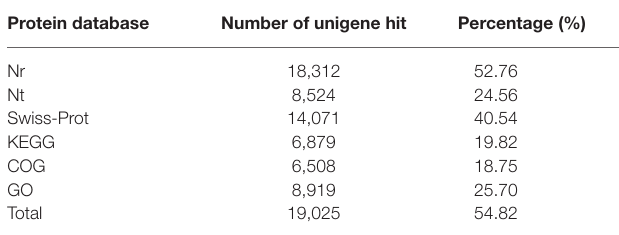
TABLE 1 | Annotations of H. parallela unigenes in public databases. Protein